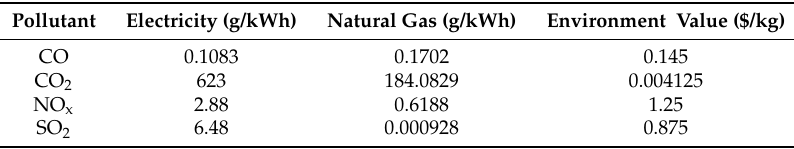
Table 5. Pollutant emission coefficient and cost